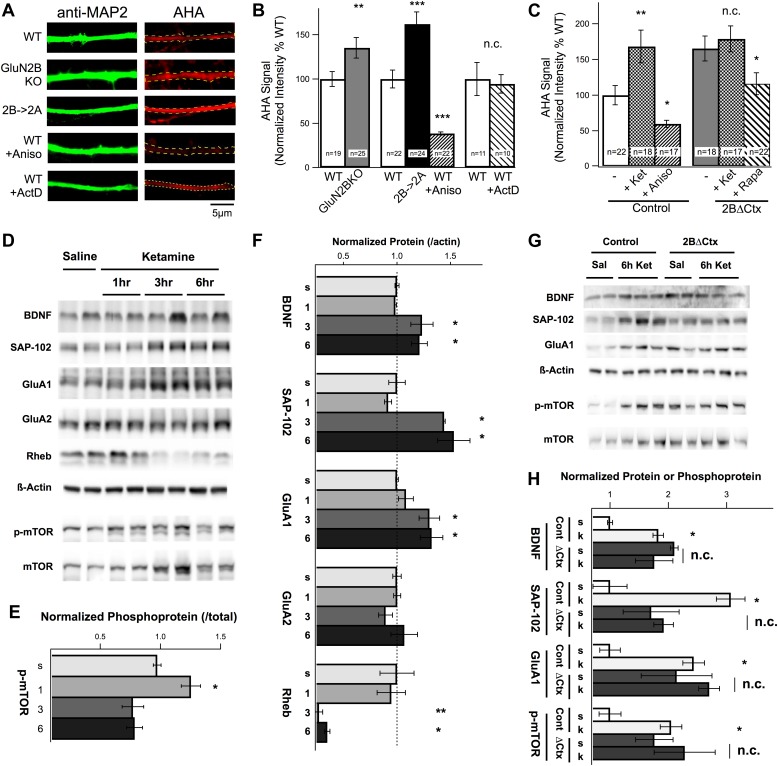
Changes in protein synthesis rates, synaptic protein expression, and phosphorylation in response to ketamine injection are occluded in GluN2B null neurons.(A) FUNCAT was used to measure rates of protein synthesis in cortical neurons. AHA signal intensity in MAP2-stained dendrites reveals relative levels of new protein synthesized over a 6-hr period. Examples of 14 DIV cortical neurons from GluN2BKO and 2B→2A as well as WT control neurons treated with the protein synthesis inhibitor anisomycin (Aniso) or transcription inhibitor actinomycin-D (ActD). (B) Combined data show significant increase in protein synthesis rates in GluN2BKO and 2B→2A neurons and suppression of basal levels by anisomycin. (C) Combined data showing the significant increase in protein synthesis rates evoked by ketamine, occlusion of this increase in 2BΔCtx and sensitivity of the AHA signal to rapamycin in 2BΔCtx neurons. (D–H) Cortical synaptoneurosomes from animals following saline or ketamine injection. Western blot analysis showed the presence of mTOR in synaptoneurosomes as well as basal levels of phosphorylated protein (p-mTOR) and expression of BDNF, Rheb, and the synaptic proteins, SAP-102, GluA1, and GluA2. (D) Expression levels, and phosphorylation status of mTOR, following ketamine injection (1, 3, and 6 hr post injection) compared to saline-injected controls. (E) p-mTOR measured relative to total mTOR levels demonstrating time-dependent changes in phosphorylation status in response to ketamine. (F) Synaptic protein expression is shown in relation to levels of actin at 1, 3, or 6 hr post ketamine normalized to saline-injected controls. Increased levels of GluA1, SAP102, and BDNF as well as decreased rheb expression seen at 3 and 6 hr post injection. (G) Example of western blots at 6 hr post-injection for both control and 2BΔCtx genotypes. (H) Quantification of the data showed significant increases in synaptic proteins in response to ketamine (k), consistent with (A–C), but also revealing occlusion of these increases in SAP-102, GluA1 and p-mTOR in 2BΔCtx animals. Data values are means ± sem. **p < 0.01; ***p < 0.001 t test with respect to WT; n.c. = no significant change.